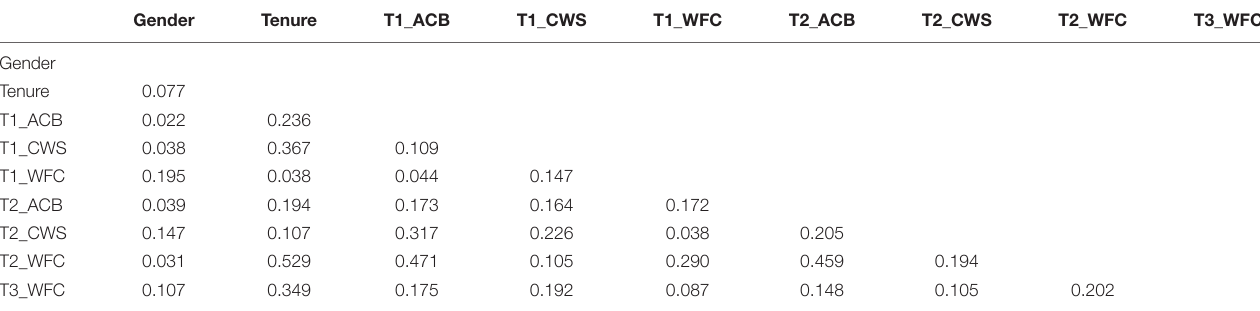
TABLE 3 | Heterotrait–monotrait (HTMT) ratios of